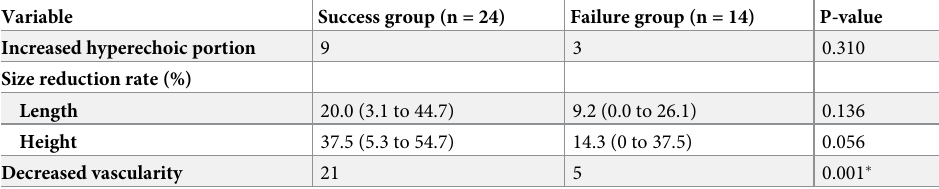
intensity on T2-weighted images and with intermediate signal intensity on T1-weighted images. Flow voids can be visible on spin-echo images. After injection of gadolinium contrast material, early intense and uniform enhancement is observed. During the involuting phase, there is an increased echogenicity on US and decreased vascularity as a result of fibro-fatty replacement. Involuted infantile hemangioma shows increased amount of fat seen as hyperin- tensity on T1-and T2-weighted images and less avid enhancement after contrast material injection. We found no significant difference in age at the start of therapy between the treat- ment success and failure groups. This finding is consistent with results from previous studies [24, 25]. According to a multicenter retrospective study, propranolol therapy was effective in infantile hemangiomas in the post-proliferative phase as well as in the proliferative phase [24]. According to another study from Schupp et al. [25], therapy started at an older age results in clinical improvements, although it is less effective than in very young children. Diagnosis is the primary role of imaging in patients with infantile hemangioma. It is optionally recommended when the diagnosis is uncertain, more than five superficial infantile hemangiomas are present, or if anatomical problems exist [25, 26]. The initial imaging modal- ity of choice is US, and MRI can be used for evaluation of anatomical structures [26]. We have newly discovered that initial and early follow-up imaging findings are related to treatment results. Whether imaging should be performed for the purpose of predicting therapeutic effect of propranolol on infantile hemangioma is outside the scope of our study. The results of this study are that evaluating blood flow and fat components in infantile hemangioma imaging Table 5. Follow-up ultrasonographic imaging findings at 3 months after starting treatment.